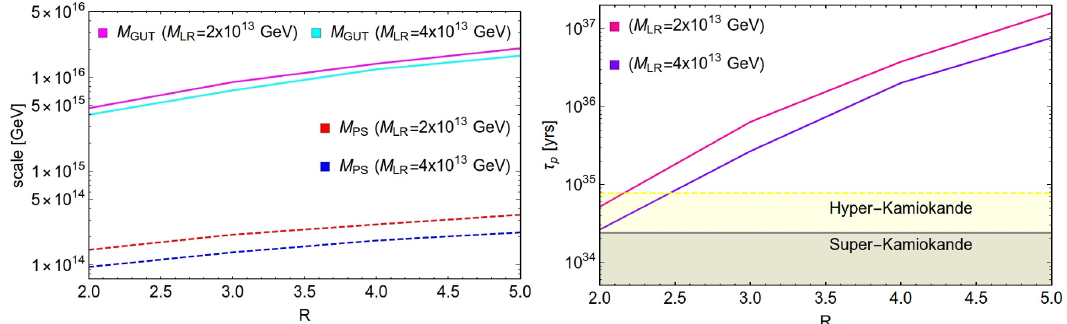
Figure 10 . Plot with threshold corrections for R = [2 − 5] . As can be seen from this plot, a threshold correction with R = 2 is enough to achieve high scale gauge coupling unification which is also consistent with the current lower bound on proton decay. Hence no additional fine-turning is required in this